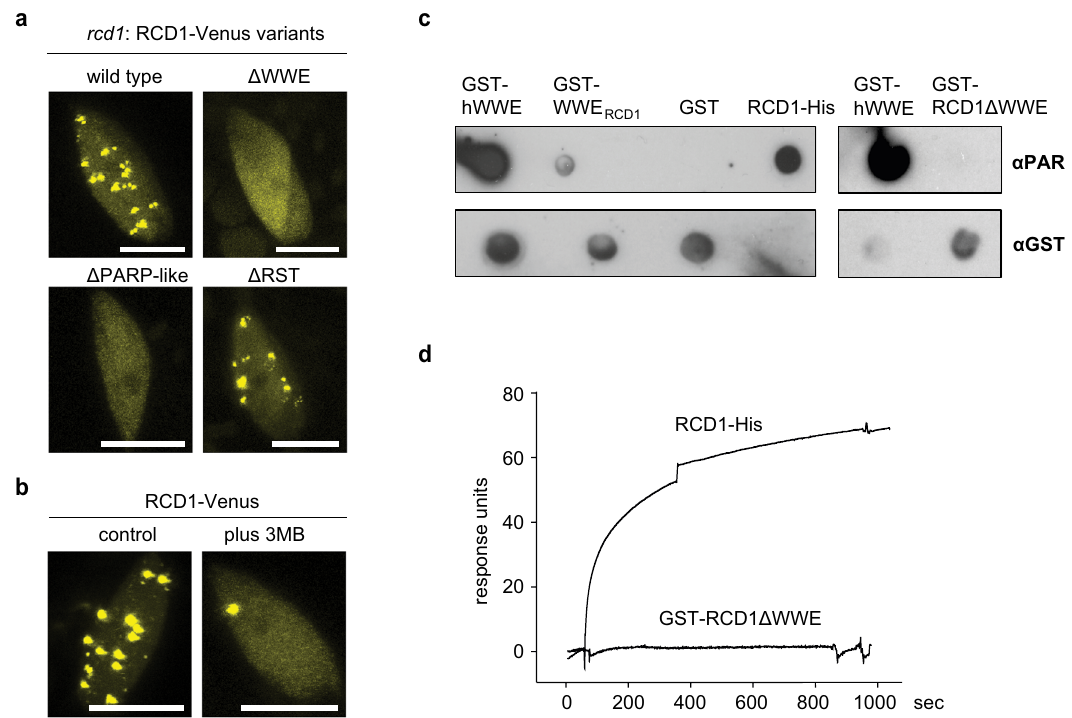
Fig. 2 Localization of RCD1 to NBs and binding of PAR depends on WWE and PARP-like domains. a Deletion of the WWE or PARP-like domains, but not the RST domain, prevents NB localization of RCD1. Confocal images were taken from stable Arabidopsis lines expressing full-length RCD1-Venus, RCD1 Δ WWE-Venus, RCD1 Δ PARP-Venus or RCD1 Δ RST-Venus in the rcd1 background. Scale bars indicate 10 µ m. b NB localization of RCD1 is diminished by PARP inhibitor 3MB. Plants expressing RCD1-Venus were pretreated overnight at 4 °C without (control) or with 3MB, after which confocal microscopy was performed. Scale bars indicate 10 µ m. c RCD1 binds PAR in vitro. PAR binding activity of immobilized GST-tagged domains of RCD1 and full-length RCD1-His was assessed by dot-blot assay using PAR-speci fi c antibody. GST tagged human WWE domain (hWWE) and GST were used as positive and negative controls, respectively. GST antibody was used to assess protein loading. d WWE domain of RCD1 is required for interaction with PAR. SPR sensorgrams of interaction between immobilized RCD1-His or GST-RCD1 Δ WWE and PAR pro fi led at 625 nM. Increase in response units shows association of PAR with RCD1-His but not with GST-RCD1 Δ